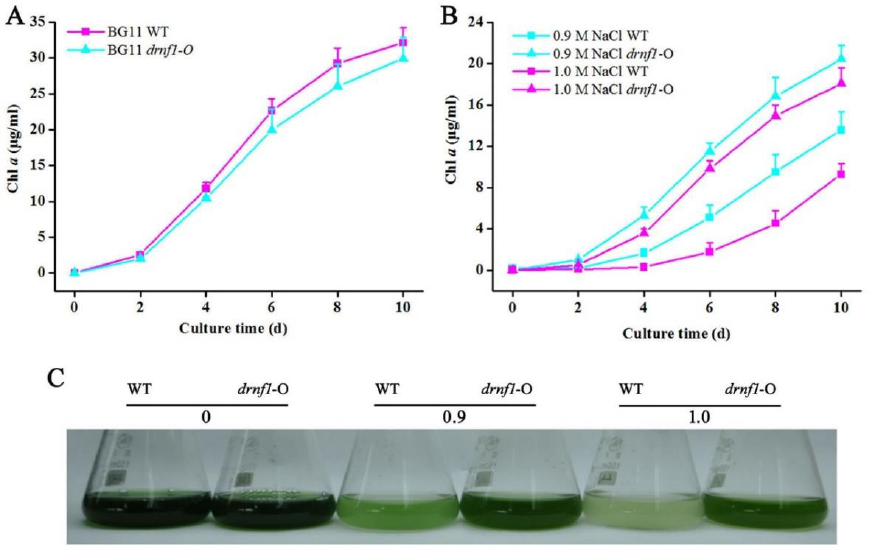
Figure 2. Identification of transgenic drnf1 Synechocystis and its resistance to short-term salt stress. ( A ) Identification of the transgenic strain using drnf1 gene-specific primers by PCR. WT: wild-type strain. drnf1 -O: transgenic strain. M: DNA marker. ( B ) Semi-quantitative RT-PCR detection of drnf1 transcription in the transgenic strain. ( C ) Changes of relative Fv/Fm during salt stresses for 3 h. Data are mean ± s.d. ( n = 5).